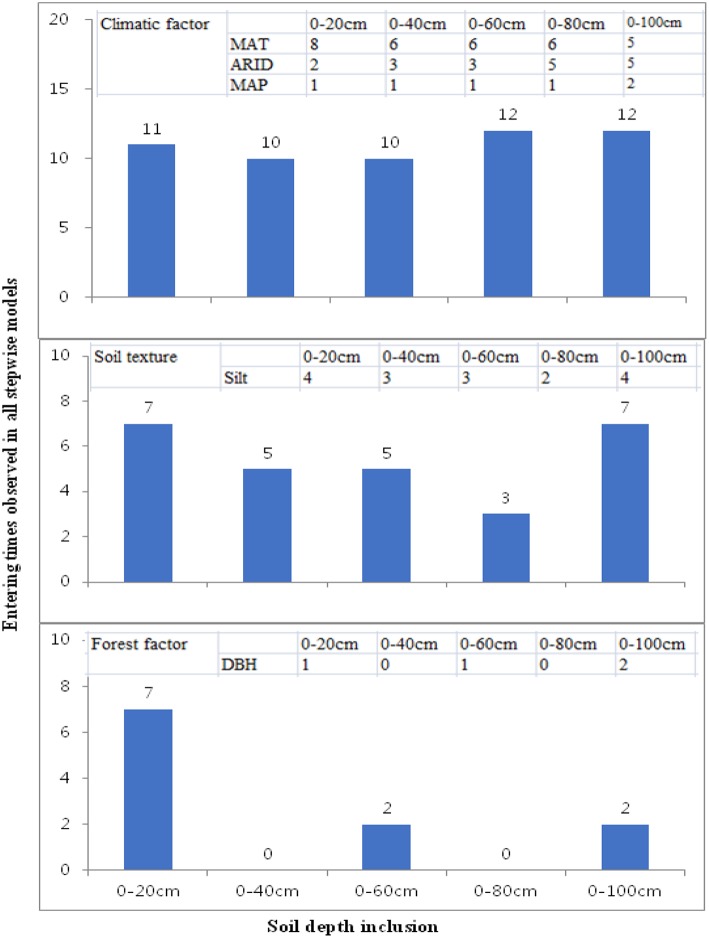
Differences of entering times of climatic factors (upper), soil texture (middle), and forest traits (lower) observed in the all stepwise regression models at different depths. Inset tables are the most observed parameters (MAT, ARID, MAP, Silt, and DBH) and their entering times all stepwise models at different soil depths. All the stepwise regression models were shown in Table A2. The more inclusion of the parameters into the stepwise models indicates their stronger contribution at that soil layers for explaining the forest-farmland differences in the studied soil properties.